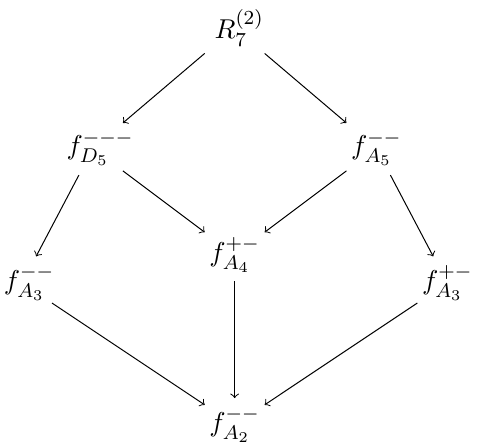
Figure 1. The web of decompositions enjoyed by the nonclassical cluster polylogarithms in terms (cid:0) (cid:1) of which δ 2 , 2 R (2) is subalgebra constructible [72]. 7 (cid:0) R (2) (cid:1) in [72]. In this diagram, each function f s 1 ...s n for δ 2 , 2 7